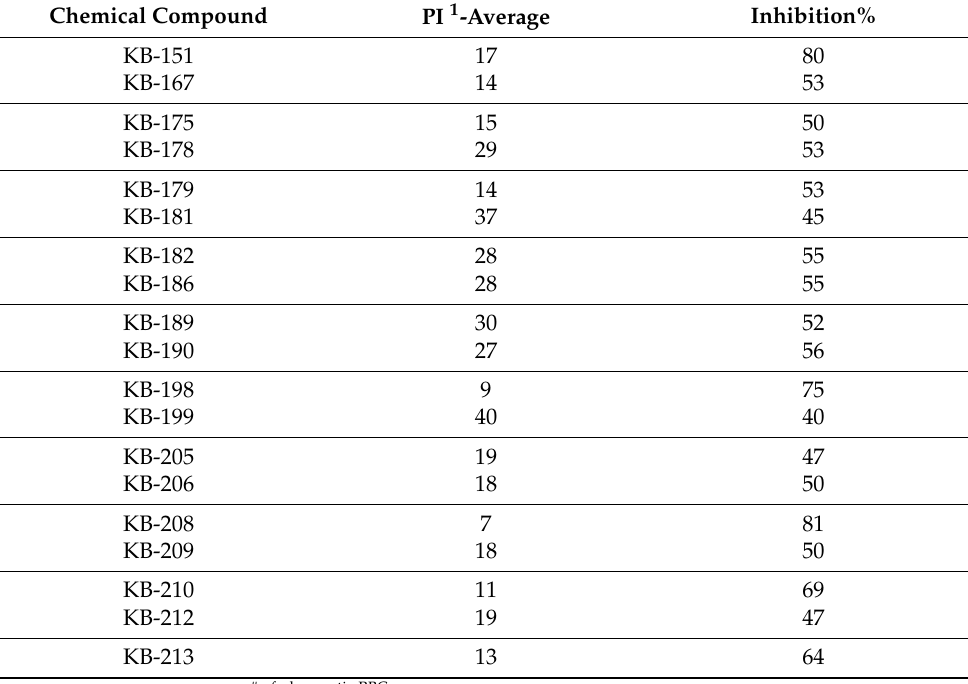
Figure 1. Selection process of compounds screened in vitro for the inhibition of phagocytosis. Table 1. Compounds that inhibited anti-D-opsonized Rh(D+) by ≥ 40% phagocytic